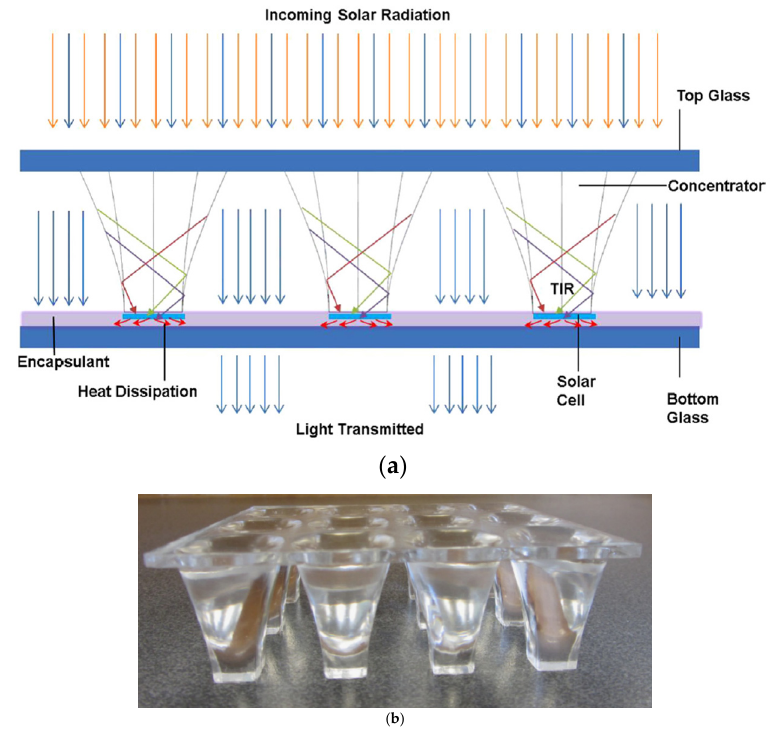
Figure 17. Schematics of a solar concentrator utilizing total internal reflection (TIR) in order to guide the incoming solar radiation to the active solar cell parts ( a ) and actual concentrator element array made of polyurethane ( b ) [69].